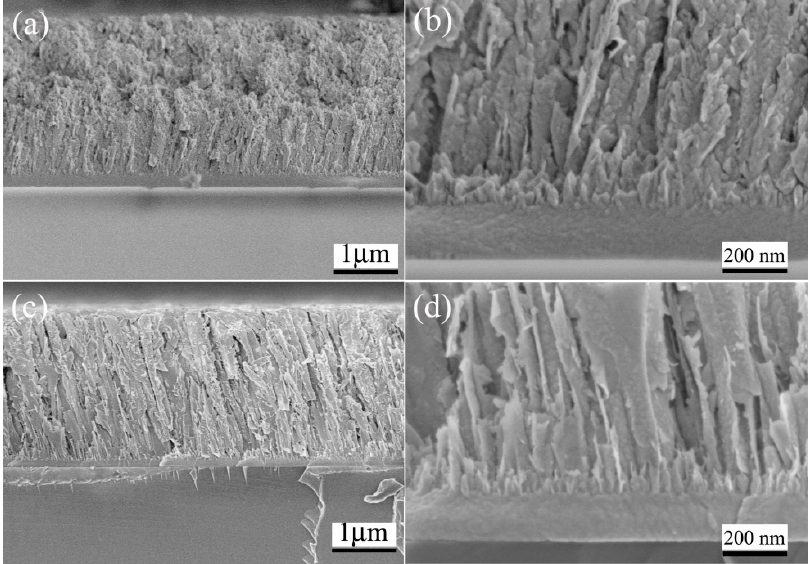
Figure 2. The cross-sectional SEM images under different magnifications for ( a , b ) WS 2 -40 film and ( c , d ) WS 2 -RT films.